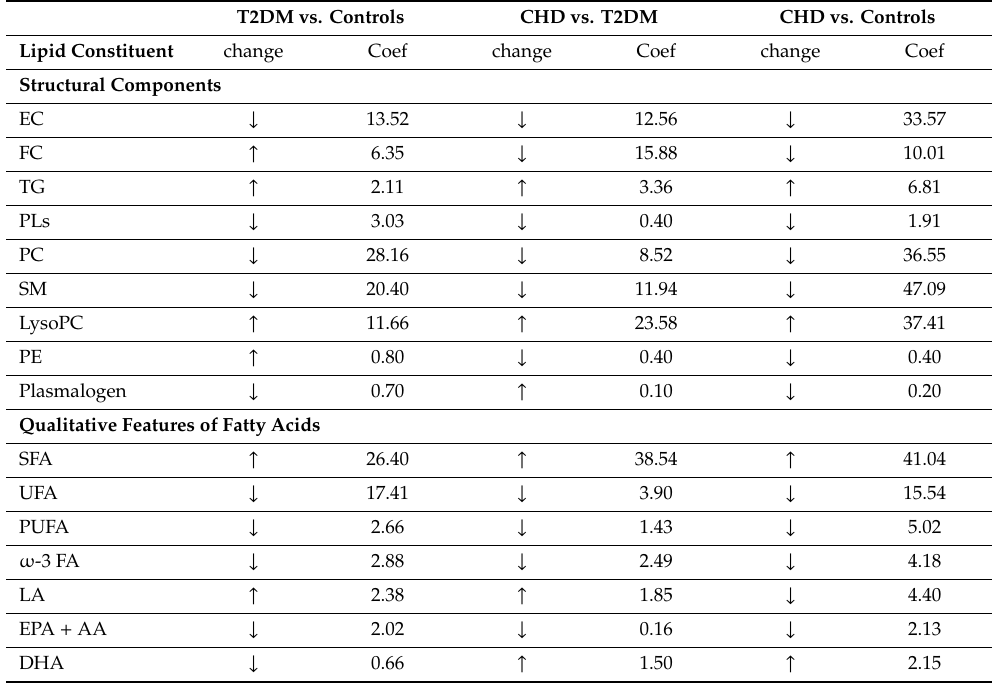
Table 2. Untargeted analysis (relative significance in the groups’ separation) of HDL lipoproteins of the studied groups. T2DM vs. Controls CHD vs. T2DM CHD vs.